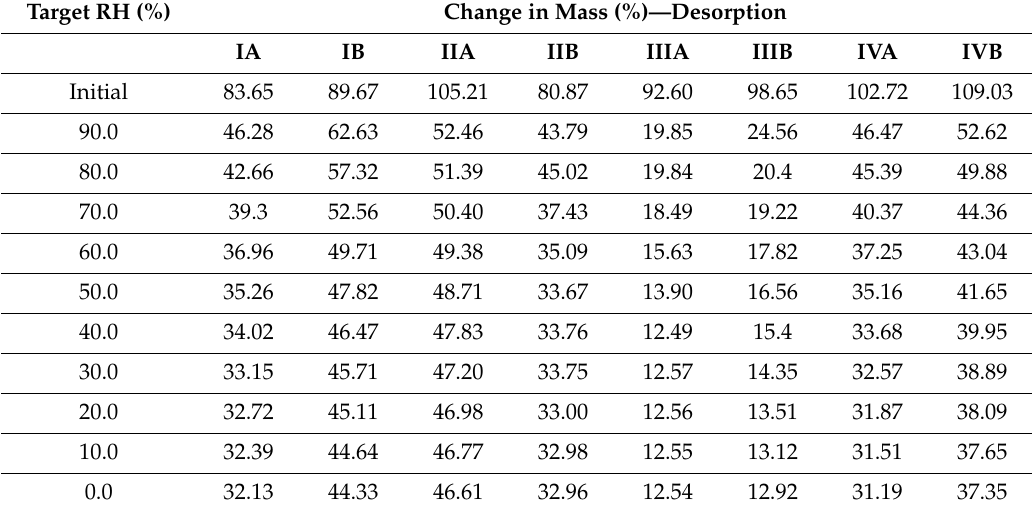
Table 7. Target relative humidity (decreasing steps) and % change in sample mass through moisture content loss